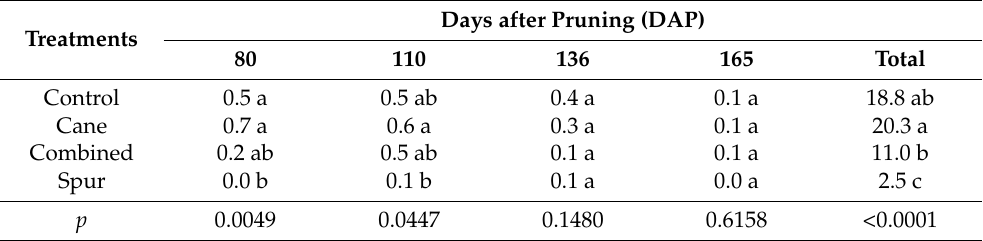
Table 2. Bloom intensity (flowers/cladode) along the season in response to different pruning treatments. Days after Pruning (DAP) Treatments 80 110 136 165